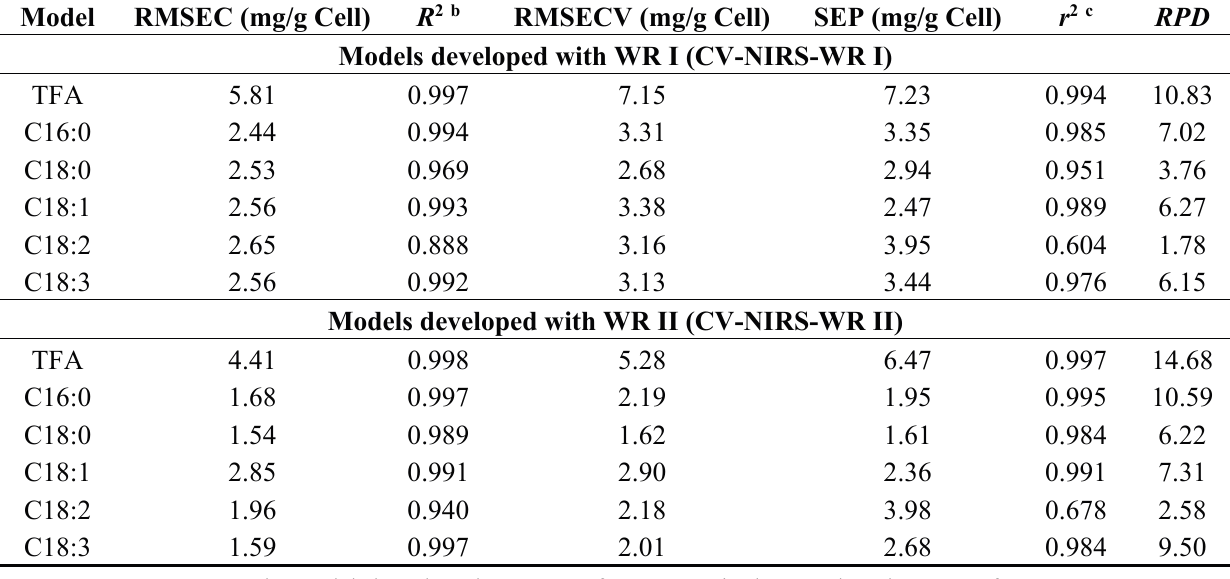
Table 2. Partial least squares 1 (PLS 1) analysis results of C. vulgaris using CV-NIRS WR I and WRII a models.